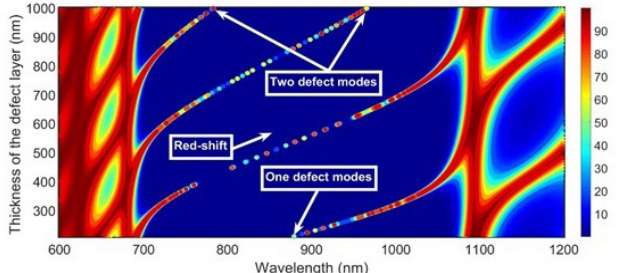
Figure 4. Transmittance spectra of defected 1D-PC by increasing the thickness of the defect layer for TBN at N=7 and incident angle 0 0 θ=